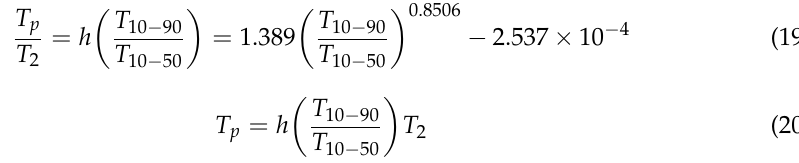
IEC method + Previously developed formula